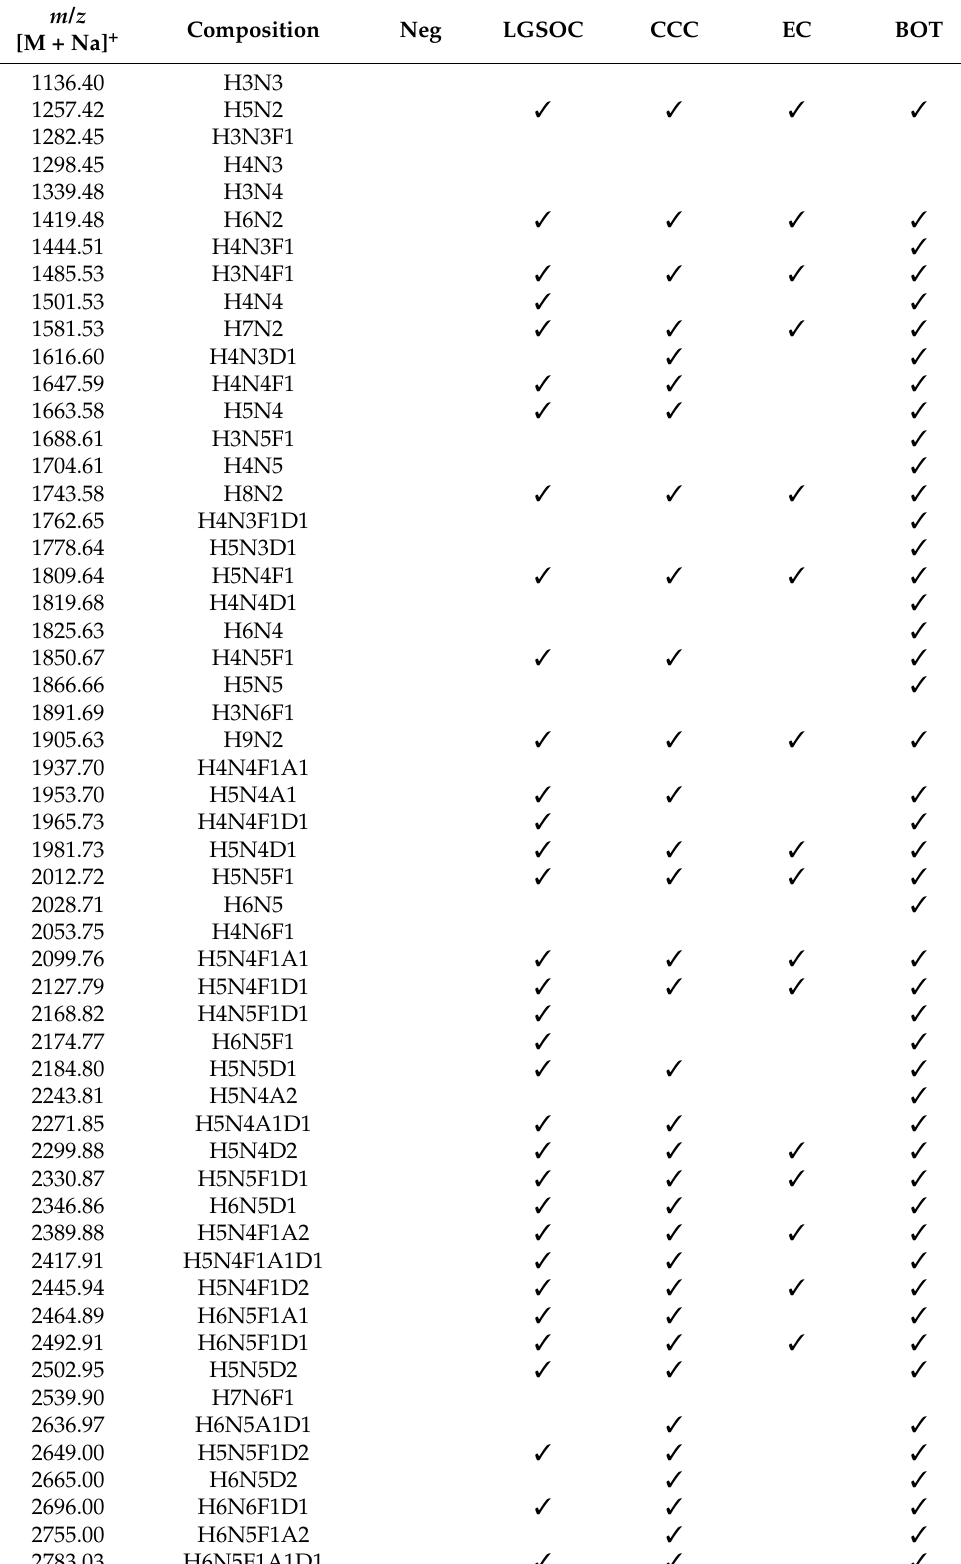
Table 1. N -Glycan structures detected by MALDI-MSI across all investigated tissue